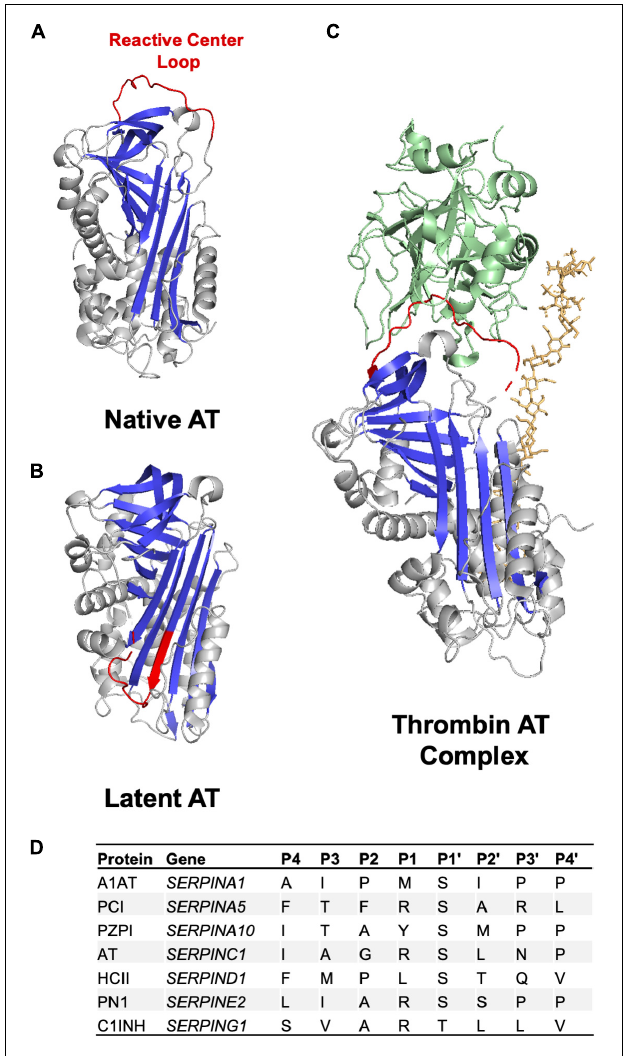
FIGURE 2 | Anticoagulant SERPIN structure and RCL. (A) Crystal structure of the anticoagulant SERPIN AT in the native conformation with a protease accessible RCL (B) Crystal structure of AT in the latent conformation in which the RCL is buried in the protein body and inaccessible to protease. The AT RCL is colored red, β sheets are colored in blue and α helices in gray. (C) Crystal structure of AT in complex with thrombin (green) in the presence of heparin (orange). Images made in PyMol using PDB files 1T1F, 2BEH, and 1TB6. (D) Amino acid residues in anticoagulant SERPINs in the P4-P4’ region of the